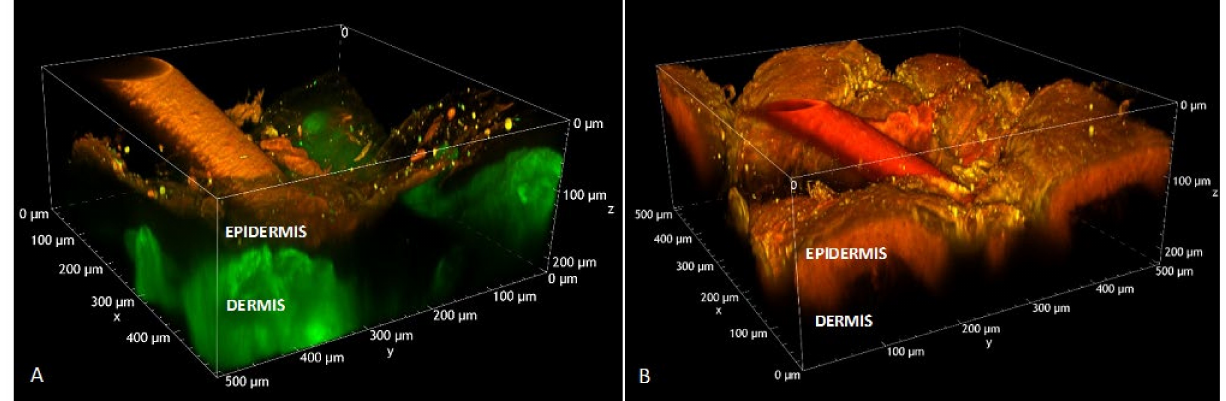
Figure 7. A 3D rendering of porcine skin samples, highlighting hair follicles. In panel ( A ), the reference sample is treated with saline solution, while in panel ( B ), we see the skin after contact with Nile red-loaded TPGS micelles. The retention of the Nile red within the epidermis is shown. (Reproduced from [200] under the Creative Commons Attribution